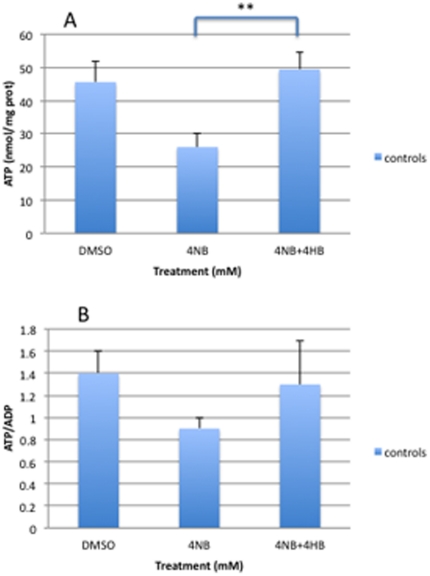
Adenine nucleotides levels in control skin fibroblasts (n = 5) after co-treatment with 4 mM 4-NB+2 mM 4-HB (ATP in panel A and ATP/ADP in panel B).The values are nmol/mg-protein (** P<0.01 vs. controls; ***P<0.001).